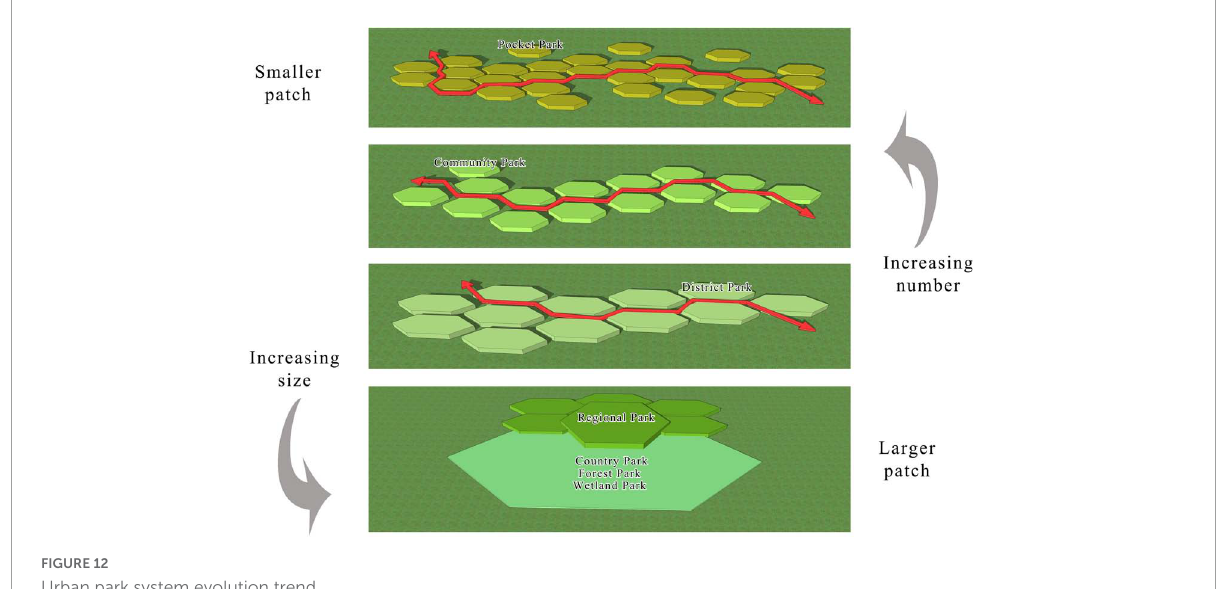
FIGURE12 Urban park system evolution trend.